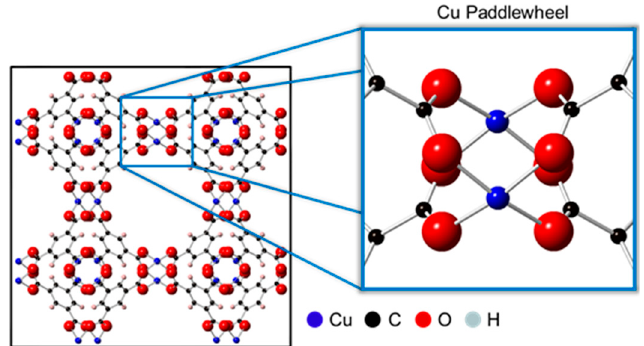
Figure 1. Unit cell (left) of the HKUST-1 metal-organic framework system ((100) crystal face) [10]. HKUST-1 is composed of four benzene-1,3,5-tricarboxylate organic ligands coordinated to Cu 2+ dimer. Highlighted is the copper paddlewheel structure (right) characteristic of the HKUST-1 system. Each Cu 2+ dimer completes its octahedral coordination sphere with two axial positions (vacant here) opposite of the Cu-Cu vector.